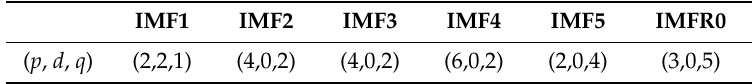
Table 7. Autoregressive integrated moving average model (ARIMA) model structures of VMD